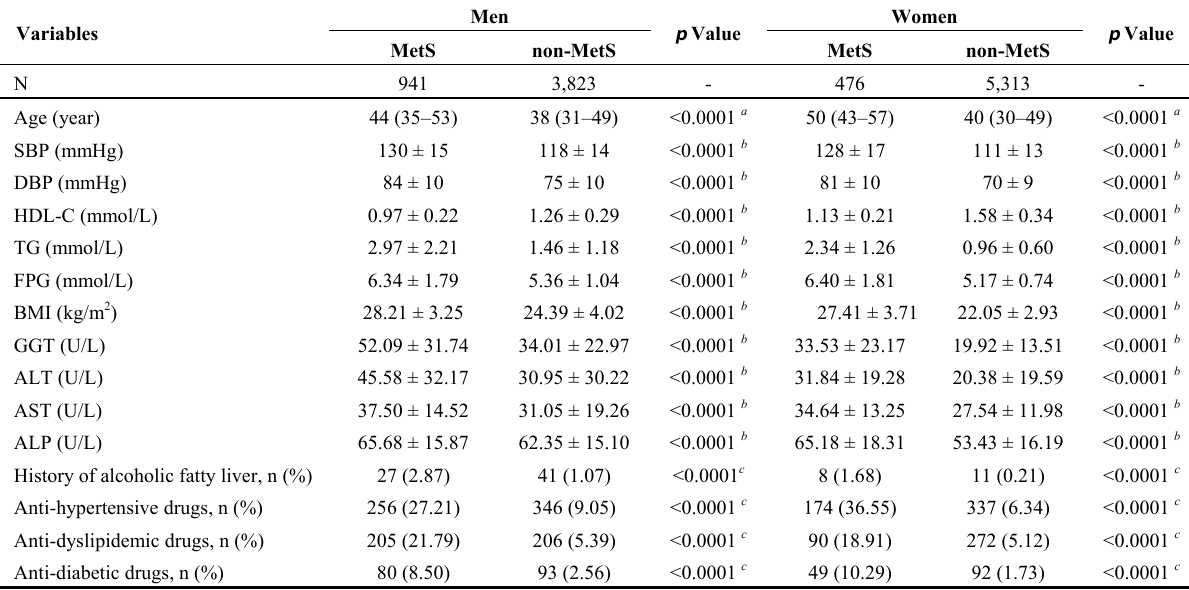
Table 2. Basic characteristics and hematological parameters by